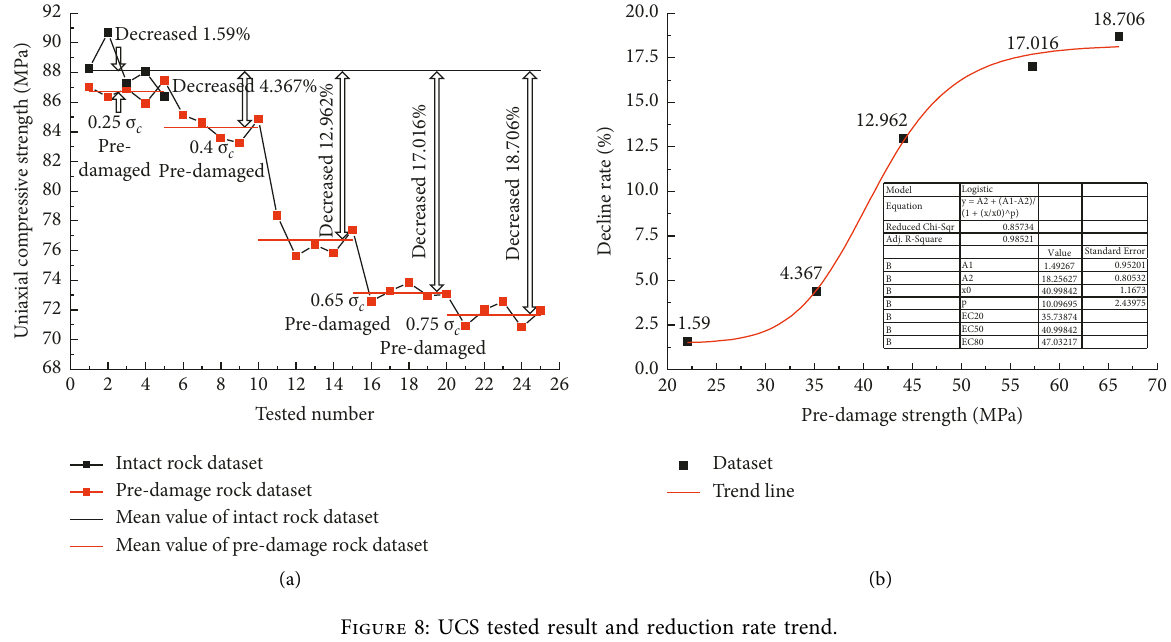
Figure 8: UCS tested result and reduction rate trend.